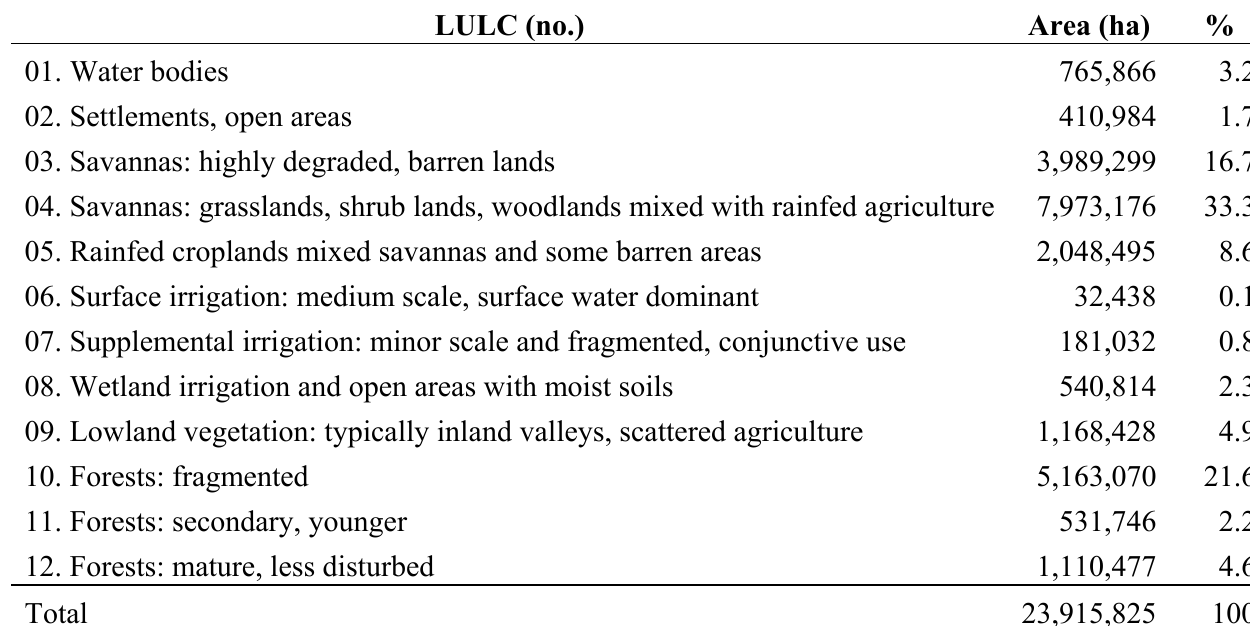
Table 3. Distribution of land use/land cover for the 12 final classes in